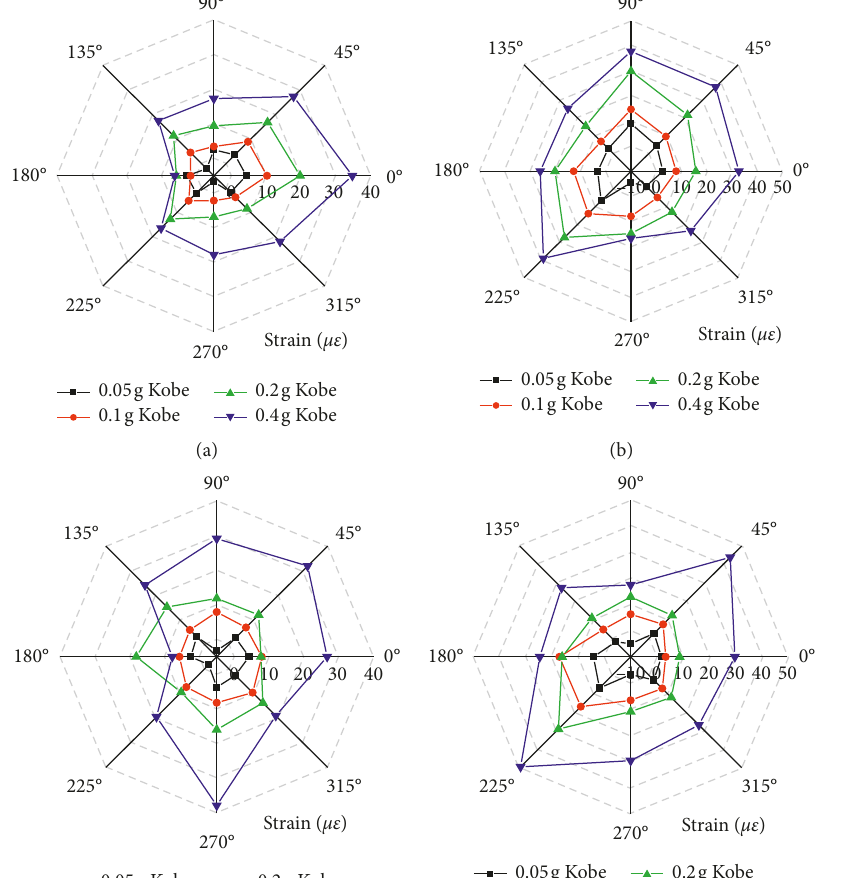
Figure 16: Mechanism of the SAL.